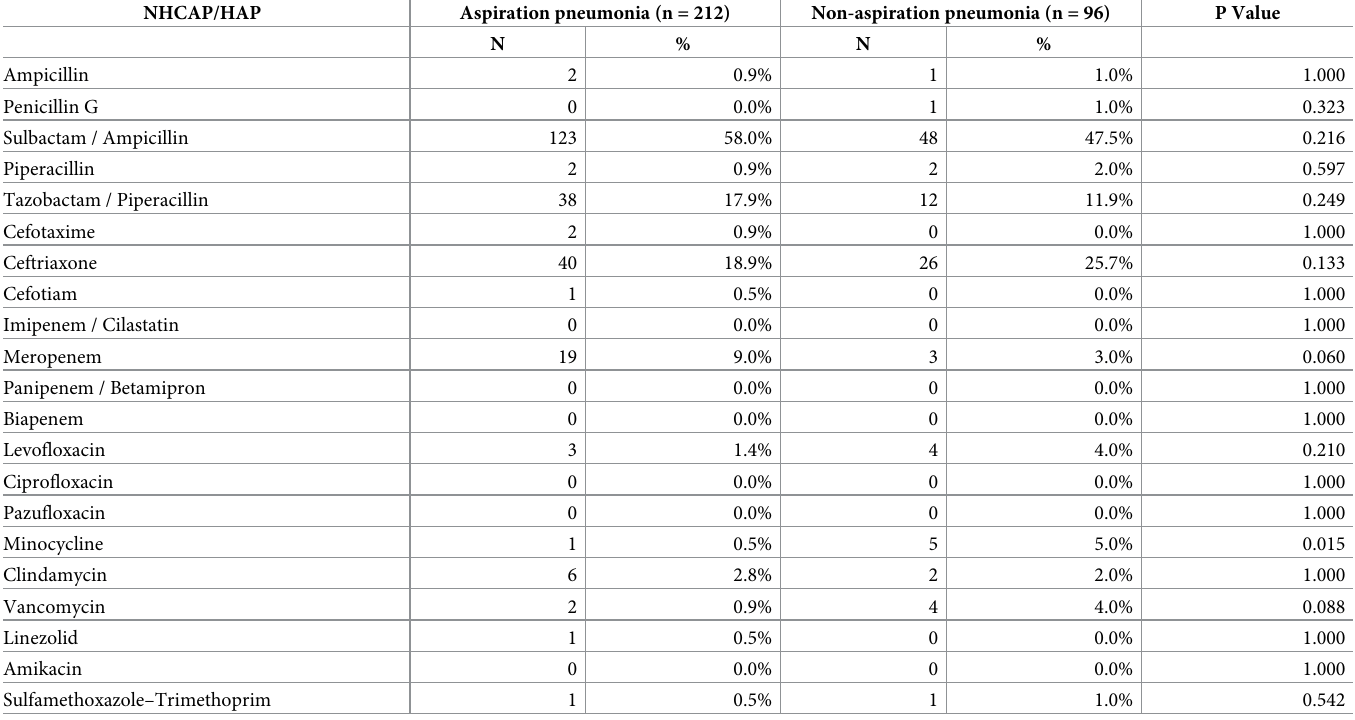
Table 9. Selection of antibiotics in nursing- and healthcare-associated pneumonia and hospital-acquired pneumonia (NHCAP/HAP).